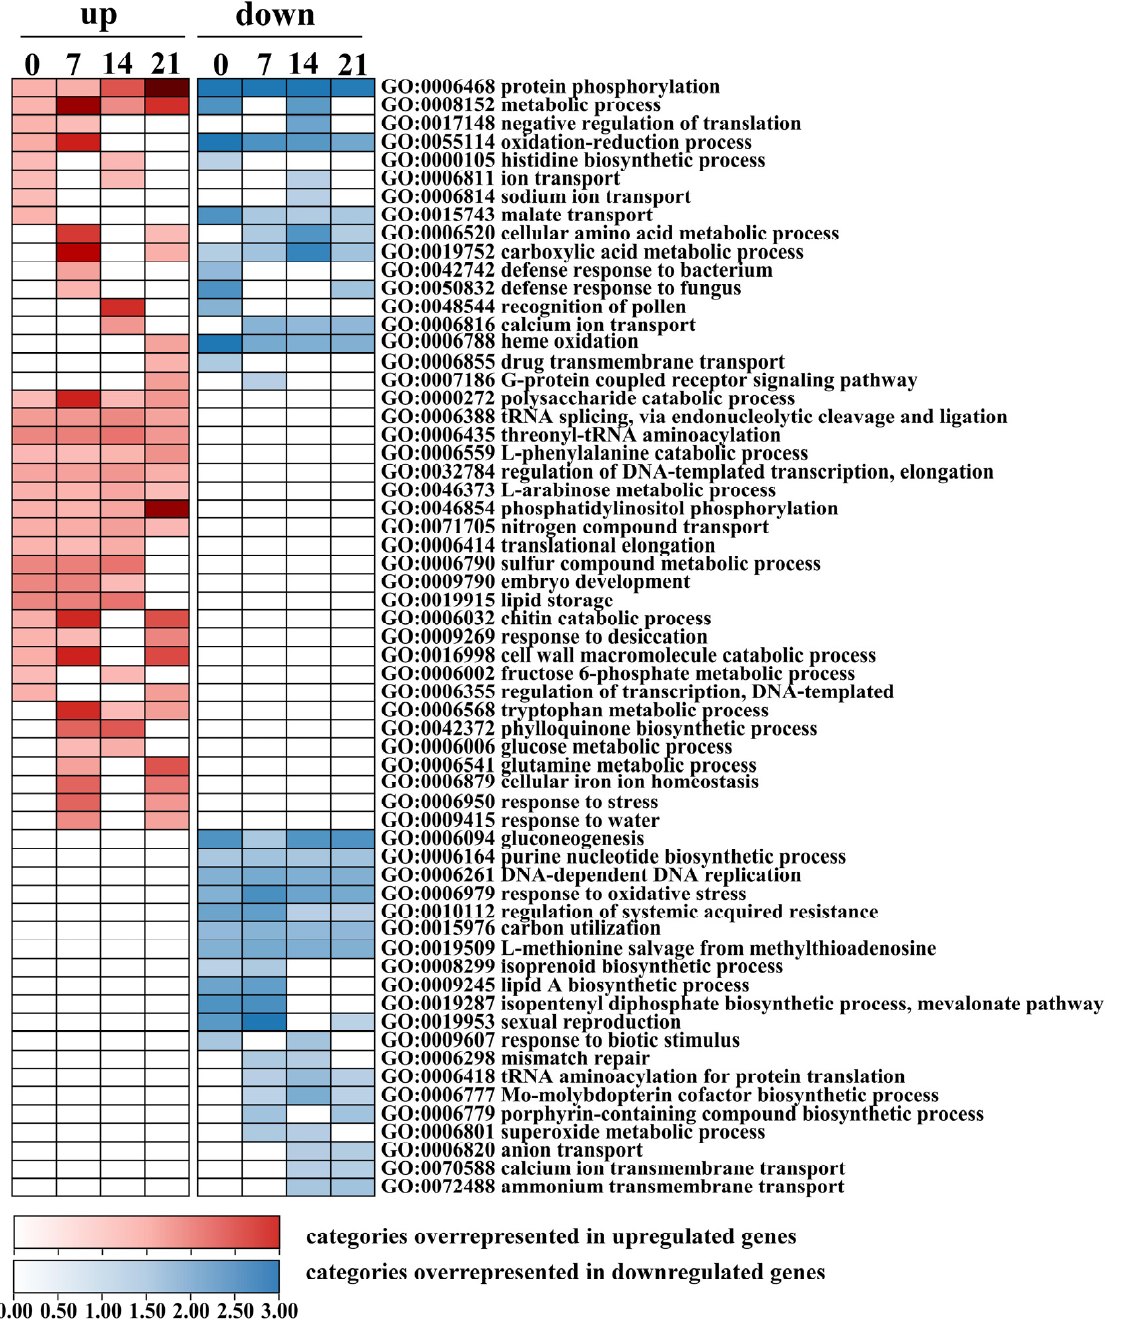
Figure 4. The biological process of GO categories in time course comparisons between A9-29 and Hua30. The categories are remarkably enriched ( p < 0.05) in either upregulated or downregulated genes. Negative log10 ( p -value) was performed for each category enrichment test and subsequently plotted for each time point.